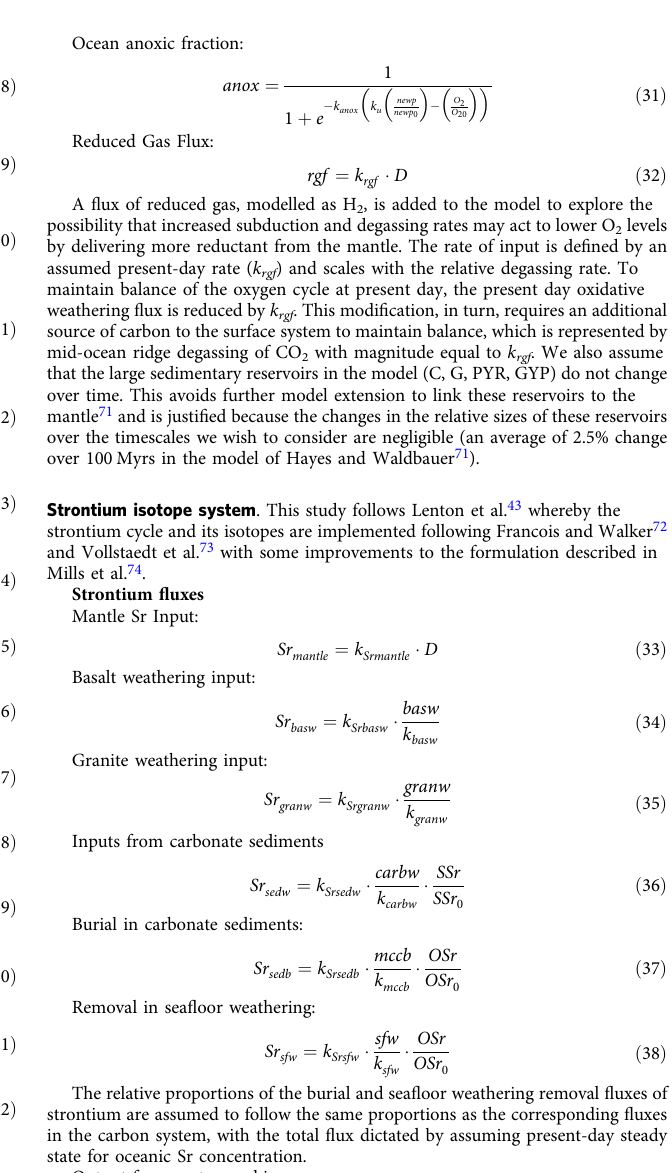
Although there is no fractionation of Sr isotopes associated with the input and output fl uxes to the ocean, decay of 87 Rb to 87 Sr in fl uences the 87 Sr/ 86 Sr ratio over long timescales (and is responsible for the differing 87 Sr/ 86 Sr values between different rock types). The decay process is represented explicitly in the model: ¼ 87 Sr = 86 Sr 87 Sr = 86 Sr granite 0